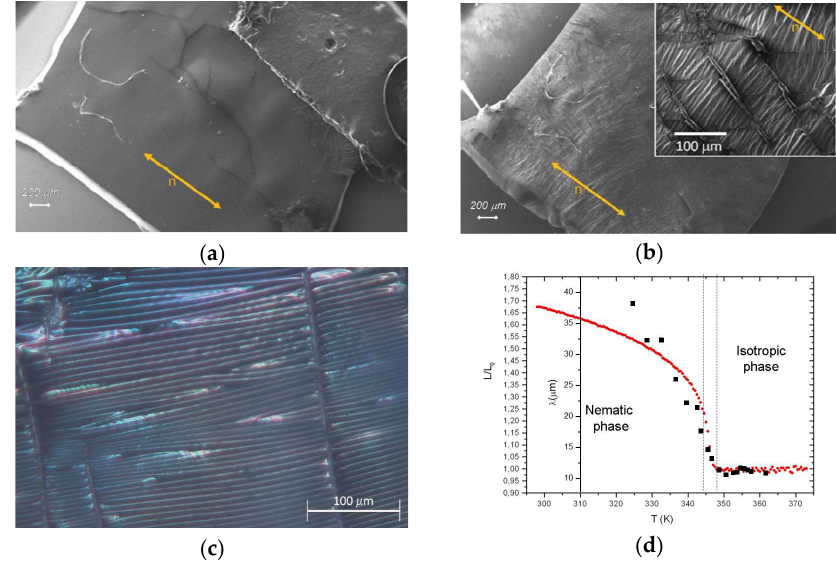
Figure 17. SEM images showing the surface of the LCE/PEDOT:PSS composite ( a ) before and ( b ) after heating at T ≈ 73 °C. Direction defining nematic director ( n ) alignment is shown as an orange arrow. Inset at left of image ( b ) shows a closer view of the surface in which uniaxial microwrinkles are formed and organized in a domain-like arrangement. ( c ) Image of the surface of the LCE/PEDOT:PSS composite, observed using an optical microscope. The temperature of the sample is about 75 °C, i.e., in the isotropic phase. Horizontal and parallel wrinkles, as well as vertical breaks, are clearly visible. ( d ) Wrinkle wavelength (λ) as measured by observing several images of PEDOT:PSS/LCE composites using an optical microscope (black squares) during the second cooling process, in the temperature range of 90–52 °C. Thermo-mechanic elongation (L/L 0 ) of the pristine LCE film (red circles) during the second cooling run. Vertical dot lines are added in order to put in evidence the isotropic–nematic phase transition. Reproduced with permission from the authors of [ 88 ]. Copyright (2018) Taylor & Francis.